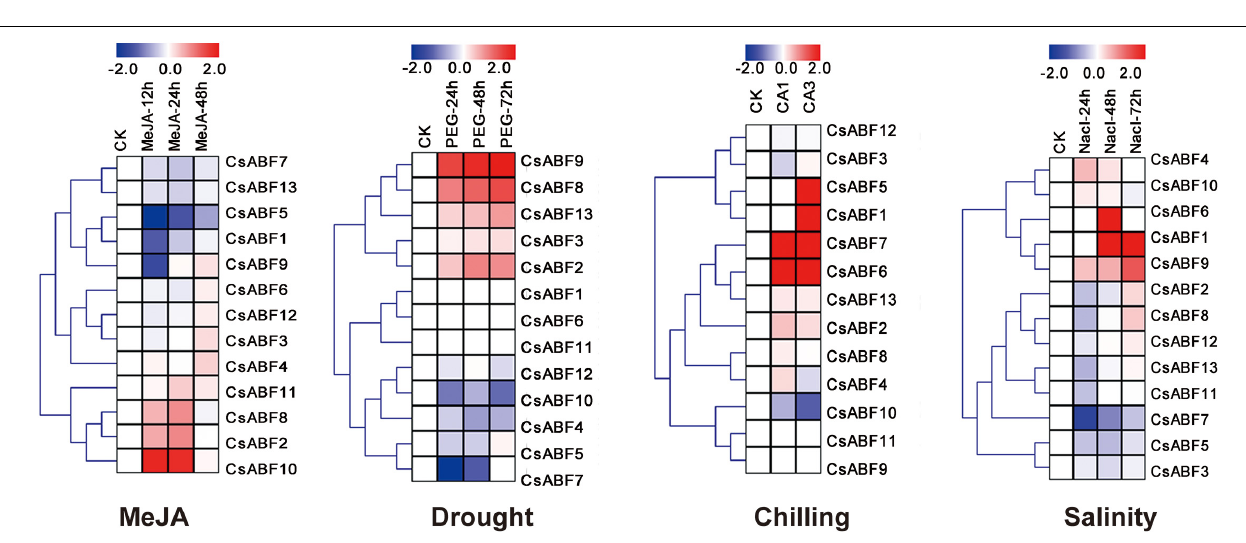
FIGURE 2 | Characteristics of the CsABF gene family members. (A) Phylogenetic tree. (B) Conserved motifs in the CsABFs. (C) Genetic structure analysis. (D) Tissue-specific expression. Different colors represent different organs, and the circle size represents the relative expression level. YL, young leaves (1st and 2nd leaves); ML, mature leaves (3rd and 4th leaves); OL, old leaves. The relative expression data were log2 transformed and diagram was drawn using the Multiple Array Viewer software.